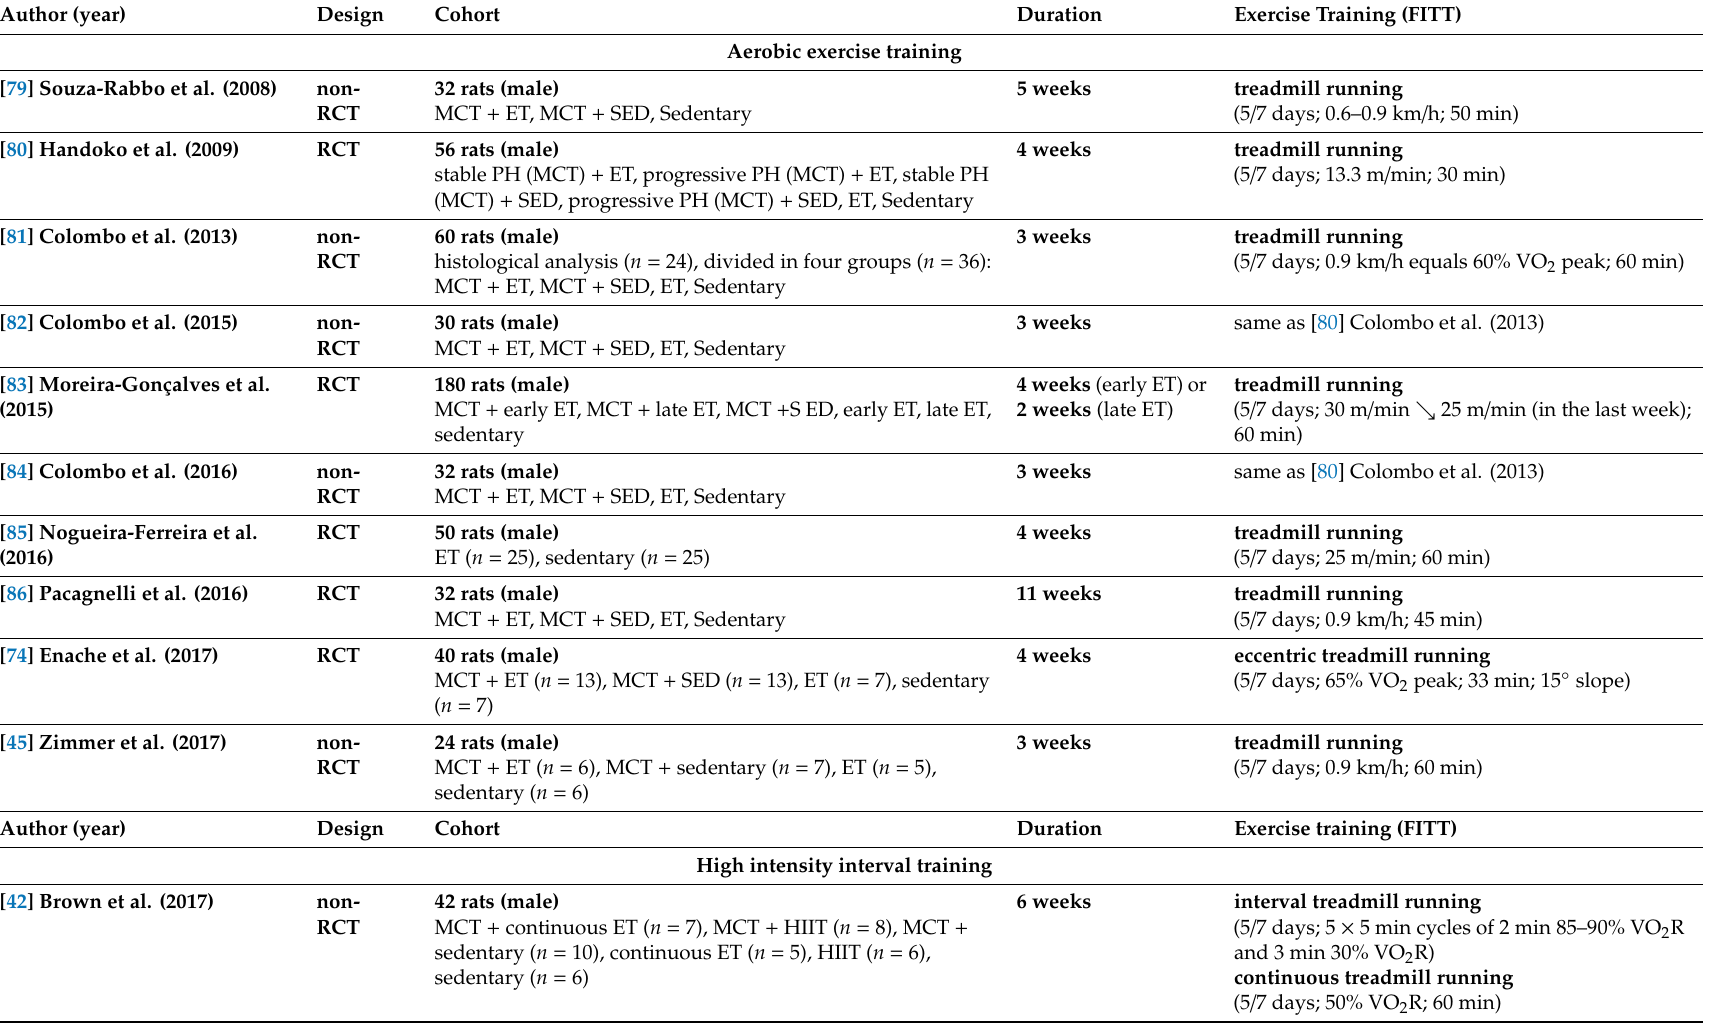
Table 5. Characteristics of included animal exercise training studies ( n =